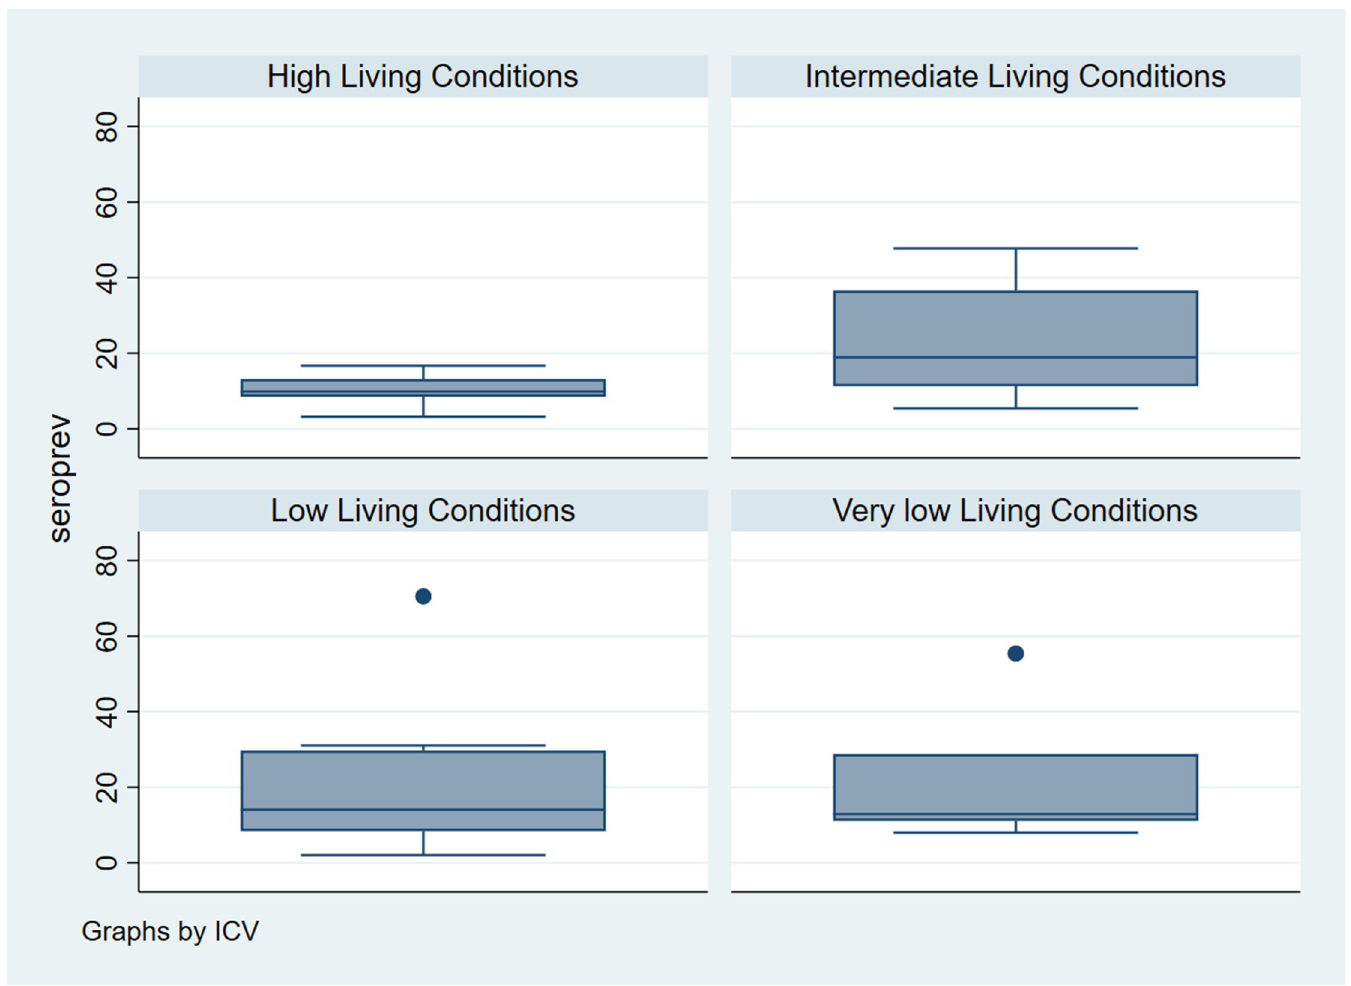
Fig 4. Seroprevalence of CHIKV by Living Conditions strata in Feira de Santana. Bahia-Brazil, 2017.